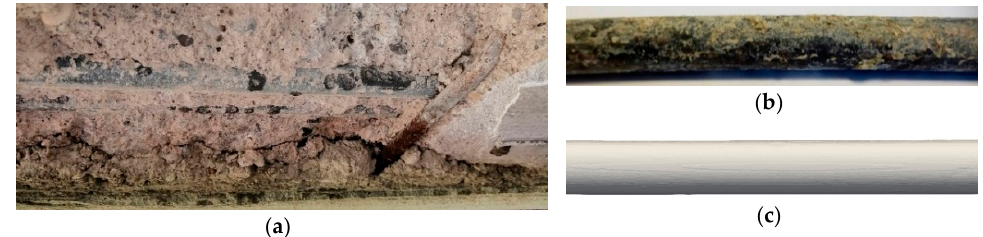
Figure 9. RC beam of the external colonnade after concrete cover removal ( a ); details of the bar as extracted ( b ) and by tomographic scan ( c ).